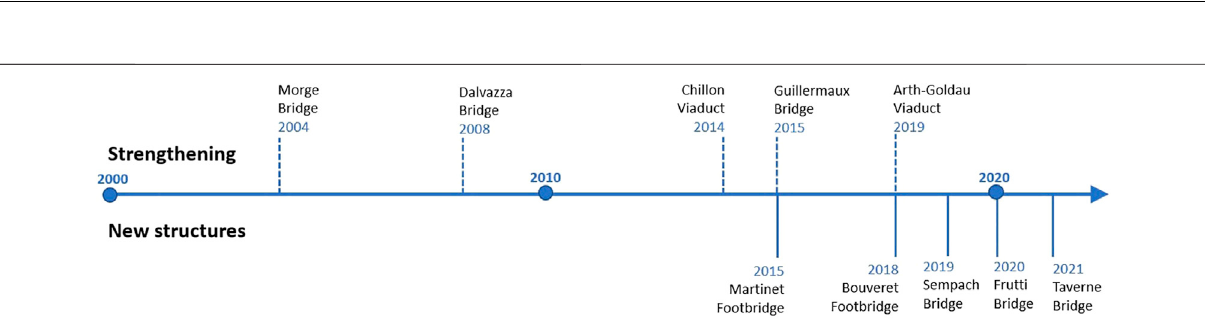
FIGURE 3 | Typical con fi gurations of structural elements combining UHPFRC and reinforced concrete. (A) UHPFRC layer has a protective function only; (B) R-UHPFRC layer has a structural resistance as well as a protective layer; (C) R-UHPFRC used for rehabilitation of corrosion damage of existing rebars. Adapted from (Denarié and Brühwiler, 2006).